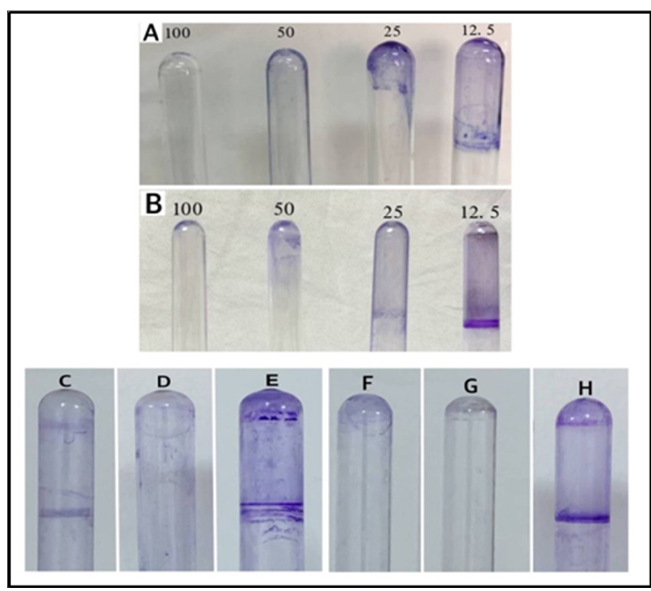
Figure 11. Biofilm formations: ( A ) AgNPs on B. cereus , ( B ) AgNPs on P. mirabilis , ( C ) lincomycin on P. mirabilis , ( D ) AgNPs–lincomycin on P. mirabilis , ( E ) positive control of P. mirabilis , ( F ) lincomycin on B. cereus , ( G ) AgNPs–lincomycin on B. cereus , and ( H ) positive control of B. cereus .